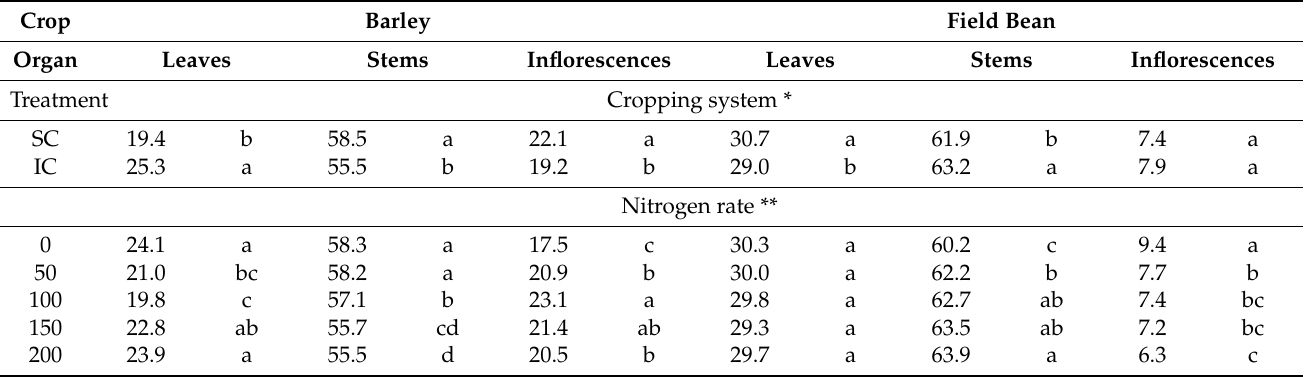
Table 1. Cropping system and nitrogen rate main effects on the allocation (%) of forage biomass among leaves, stems, and inflorescences of barley and field